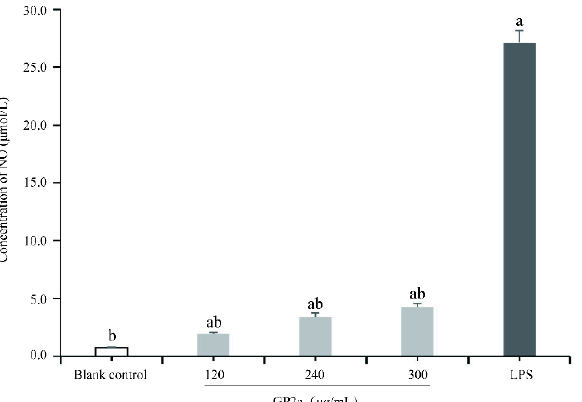
Figure 9. Effects of GP2a on nitric oxide (NO) production in RAW 264.7 cells. Untreated cells were used as blank control; Cells treated with different GP2a concentrations (120, 240, and 300 µg/mL) were used as samples; Cells treated with lipopolysaccharide (LPS) (2 µg/mL) were used as positive control. Letter a represents significant difference compared with the blank control ( p < 0.05, p < 0.01); letter b represents significant difference compared with the positive control ( p < 0.05, p < 0.01). As shown in Figure 10, the production of cytokines from the positive control and the sample groups were significantly higher than in the blank control, as indicated by mark- edly increased tumor necrosis factor- α (TNF - α), interferon (IFN) - γ, interleukin (IL) - 1β, IL-6, and granulocyte macrophage colony stimulating factor (GM-CSF) levels ( p < 0.05, p < 0.01). Particularly, the TNF- α, IFN - γ, IL - 1β, IL -6, and GM-CSF levels obtained with 300 µg/mL GP2a were significantly higher than in the blank group ( p < 0.05), but not signifi- cantly different from the positive control. GP2a seemed to induce cytokine secretion. Meanwhile, the effect of GP2a on cytokine production enhanced with increasing GP2a concentration (120 – 300 µg/mL).